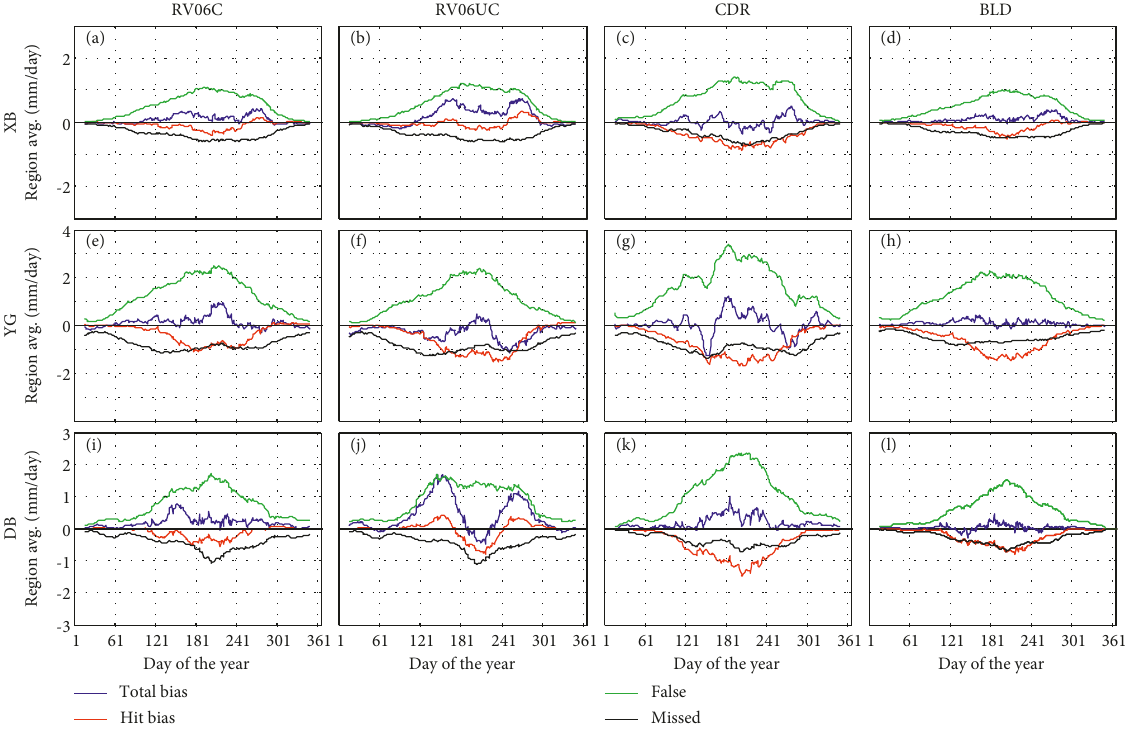
Figure 10: Same as Figure 9 except for the XB, YG, and DB subregions.